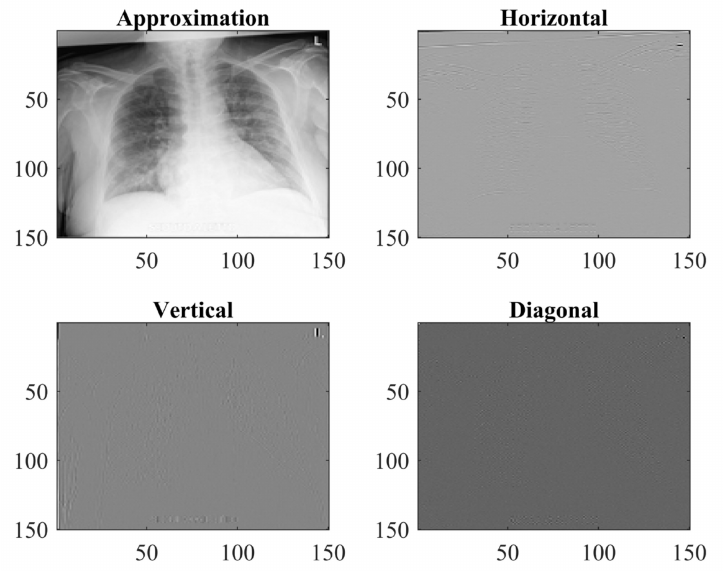
Figure 4. 2D DWT applied to chest X-ray of COVID-19-affected